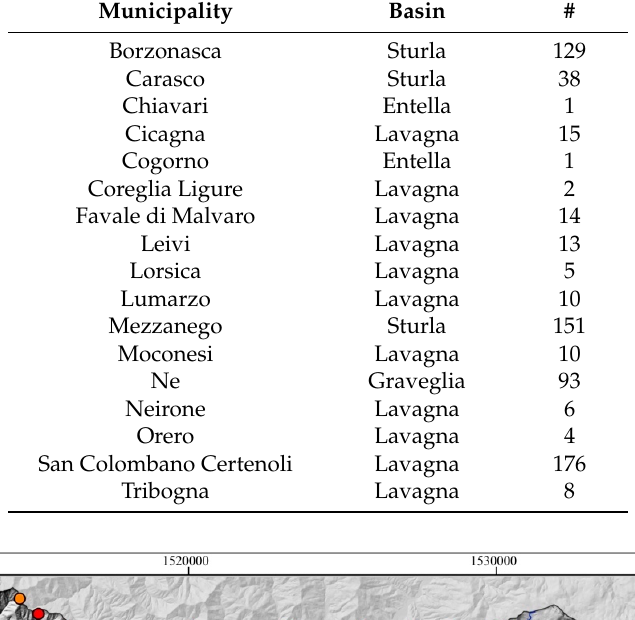
Table 3. Distribution of geo-hydrological criticalities and damage notifications in the Municipalities inside the Entella River basin over the 17-year period from 2000–2017. See Figure 1 for the location of the listed sites.